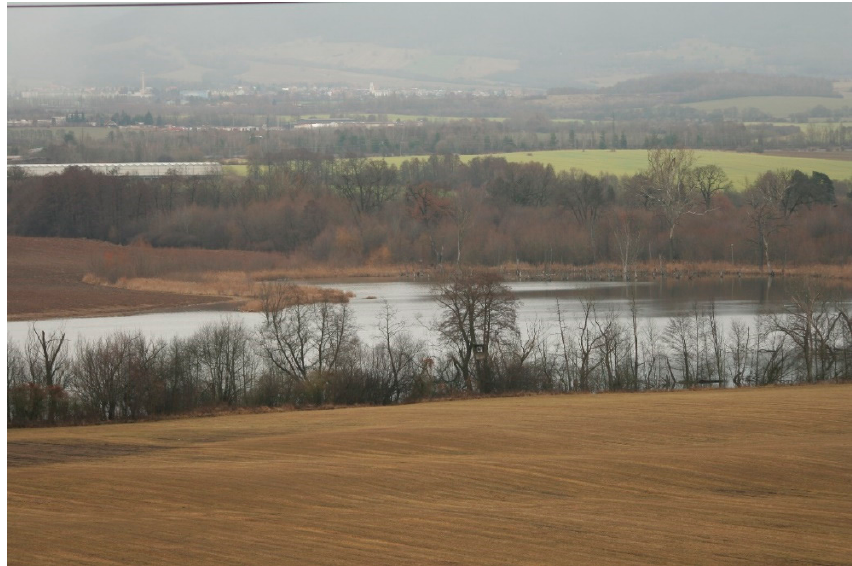
Figure 6. Stabilized wetlands are beginning to be used for recreational